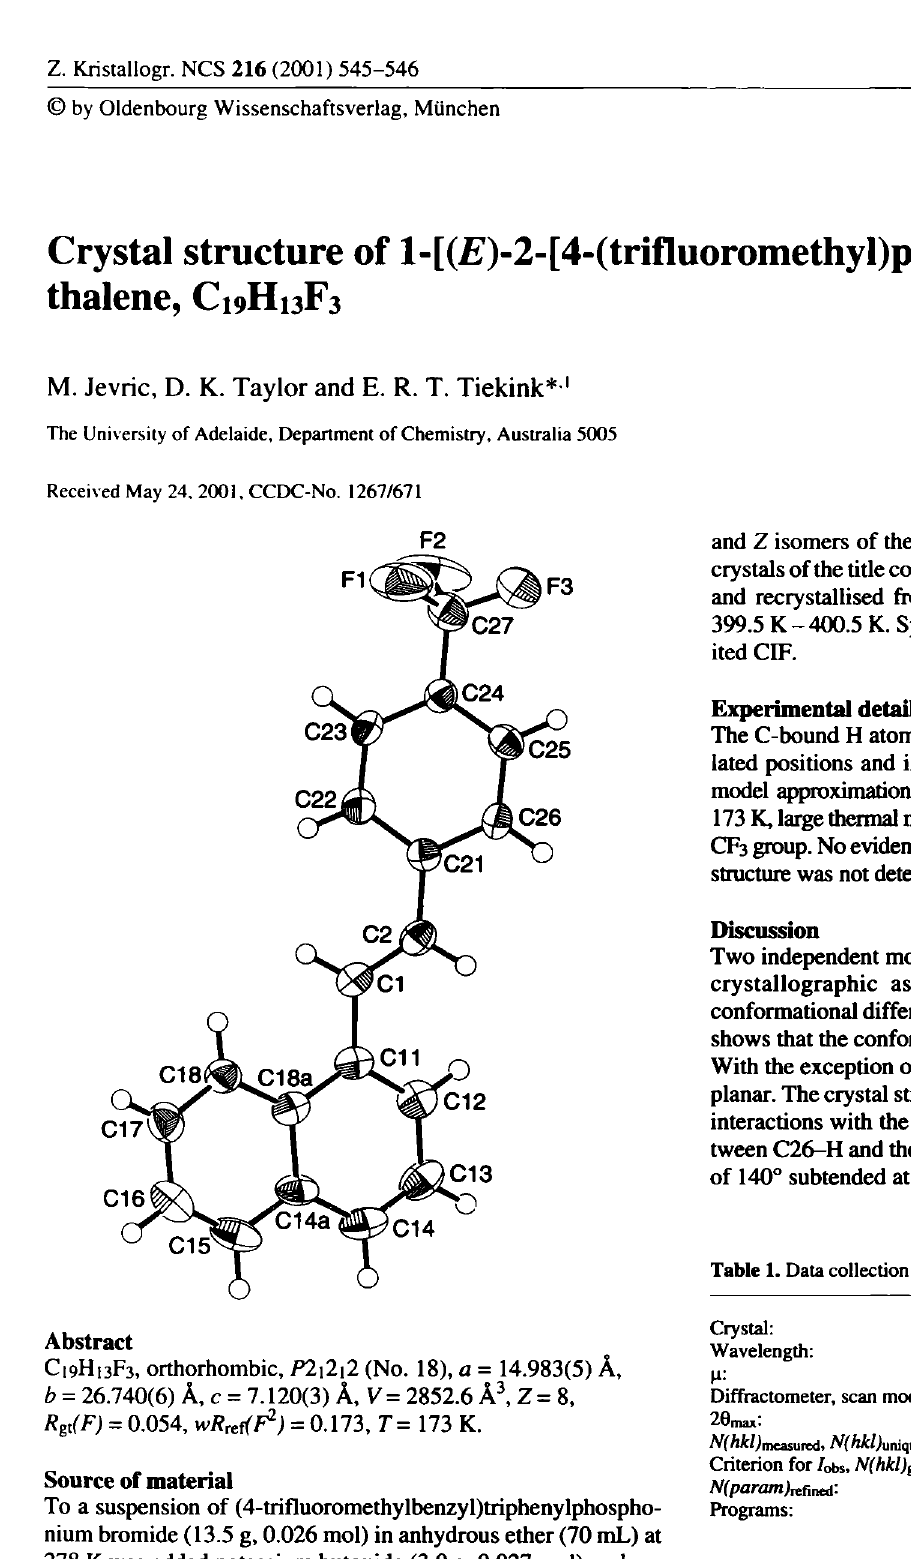
Table 2. Atomic coordinates and displacement parameters (in A 2